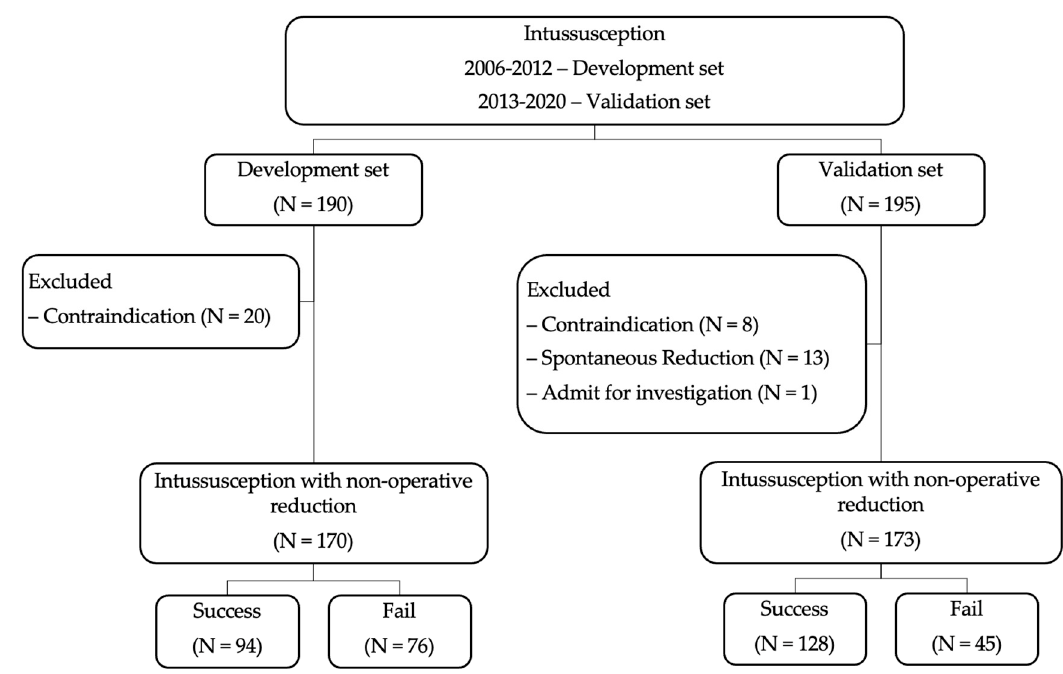
Figure 1. Study flow diagram. Table 2. Baseline characteristics between development set (N = 170) (Showing missing data) and validation set (N = 173) of intussusception